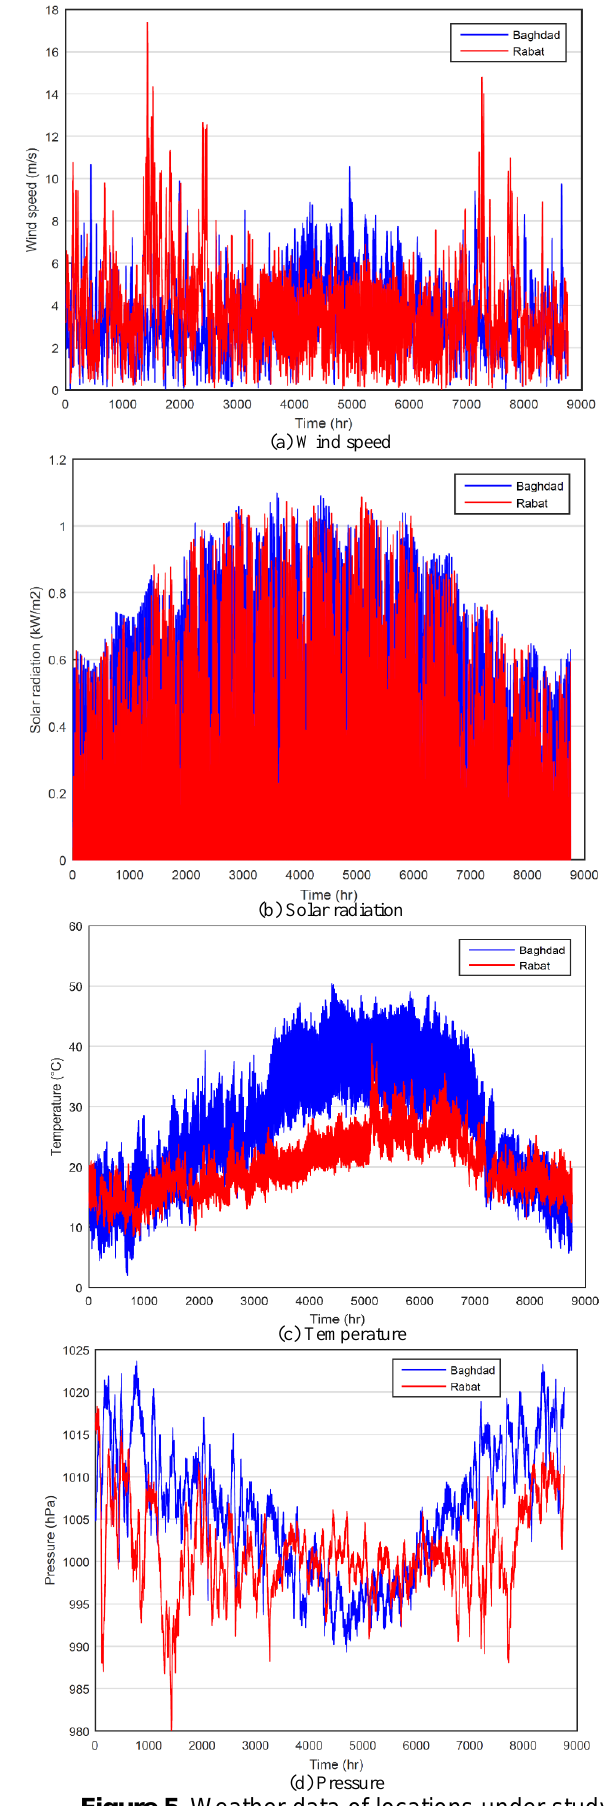
Figure 5. Weather data of locations under study